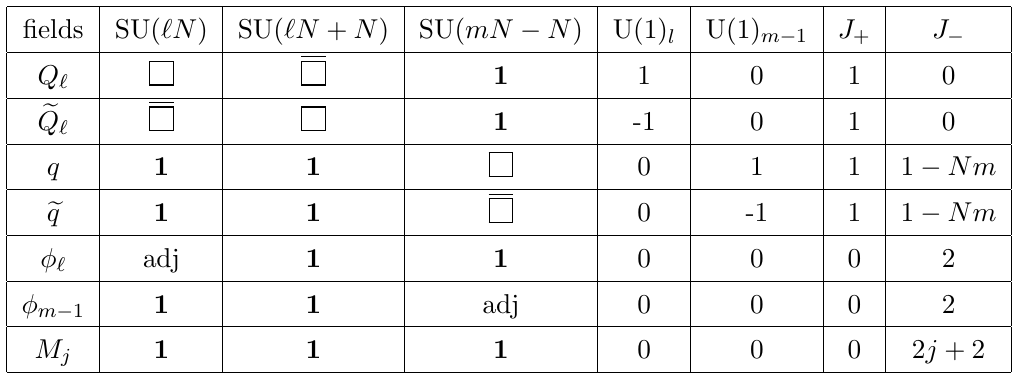
Table 1 . Matter content for the \Lagrangian description" of the ( A m (cid:0) 1 ; A Nm (cid:0) 1 ) theory. Here ‘ runs from 1 to m (cid:0) 2 and j for the M j runs from 1 ; : : : ; Nm (cid:0) 1. U(1) ‘ is a baryonic global symmetry acting on ( Q ‘ ; e Q ‘